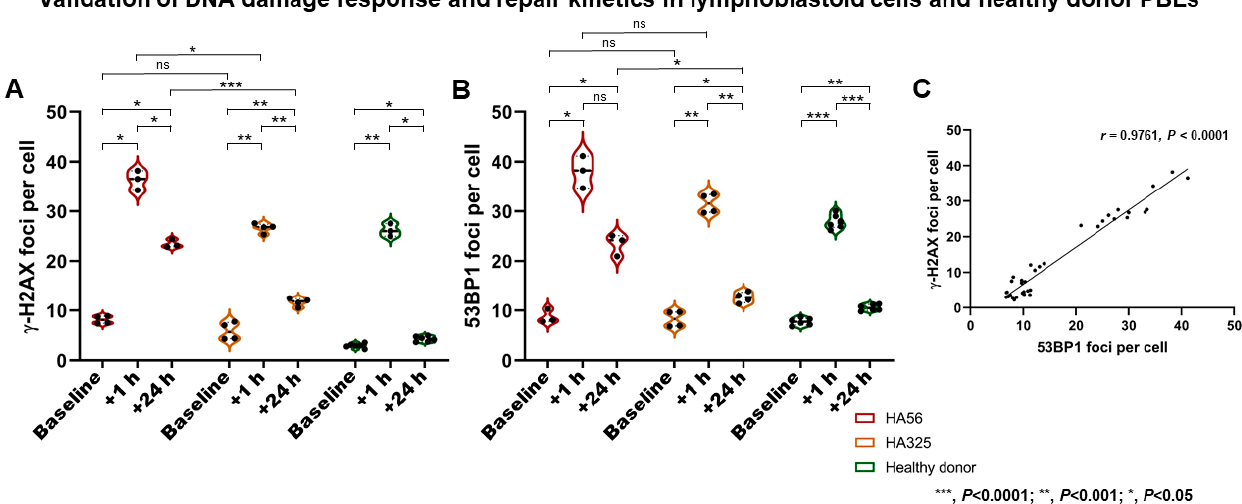
Figure 1. Validation of DNA damage response and repair kinetics analyses. ( A , B ) Following irradiation (2 Gy), immortalized lymphoblastoid cells (LCLs) and healthy donor peripheral blood lymphocytes (PBLs) showed an increase in double-strand break (DSB) marker foci at +1 h (i.e., DNA damage response (DDR)), and a subsequent decrease at +24 h (i.e., repair). The ataxia–telangiectasia (A–T) patient-derived LCL line (HA56) showed more γ -H2AX and 53BP1 foci at +1 h than the wildtype control line (HA325), and a significantly higher number of residual γ -H2AX and 53BP1 foci at +24 h. ( C ) A highly significant correlation between γ -H2AX and 53BP1 foci in LCL samples was found. *** p < 0.0001; ** p < 0.001; * p < 0.05. ns—not significant.